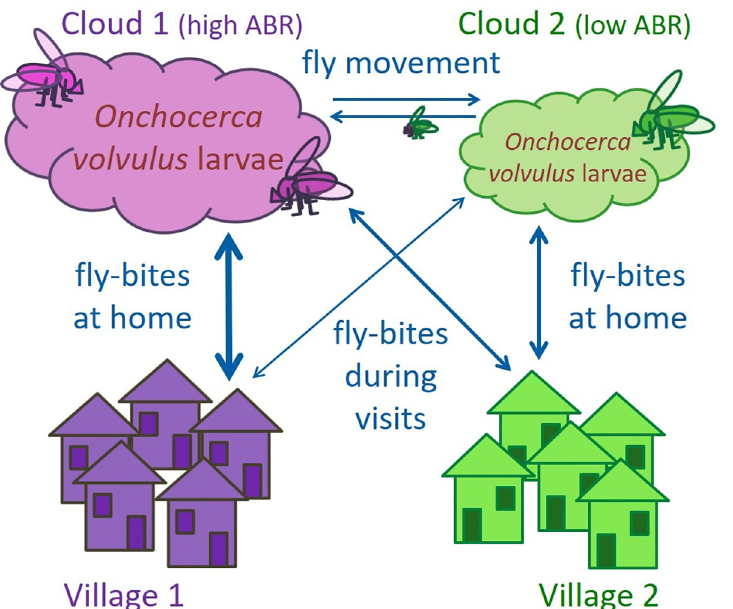
Fig 1. Graphical representation of connectivity in ONCHOSIM. The model keeps track of humans, individual adult Onchocerca volvulus worms within these humans, and the total number of worm larvae (microfilariae) that have been taken up by flies. This latter aggregate has been named the cloud. Here we model two (or three) distinct villages, each with its own cloud. Individuals spend most of their time at their home village, where through fly-bites they become infected and add to the infection-load of worm larvae in the local village cloud. The greater the annual fly biting rate (ABR) in their village, the greater the frequency of this cloud-human contact. However, individuals may also spend a proportion of their time in another village, and during this time they are infected from and add larvae to the local cloud there, with a frequency depending on the ABR in this area. The model also allows for movement of flies (with the larvae inside them) directly from cloud to cloud.